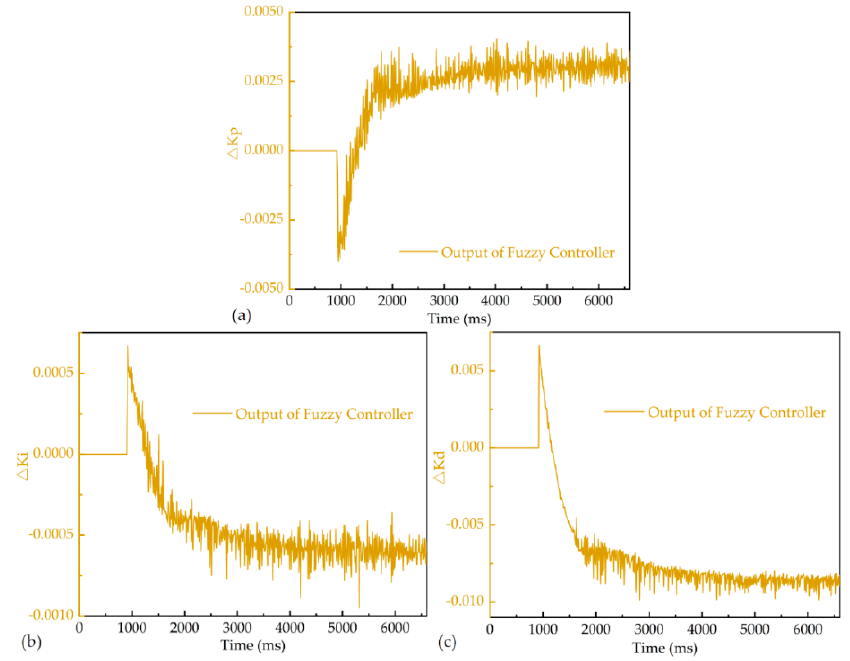
Figure 11. Variation of the output correction quantities ∆ K p , ∆ K i , and ∆ K d of the fuzzy controller. ( a ) Variation of the correction quantity ∆ K p ; ( b ) variation of the correction quantity ∆ K i ; ( c ) variation of the correction quantity ∆ K d